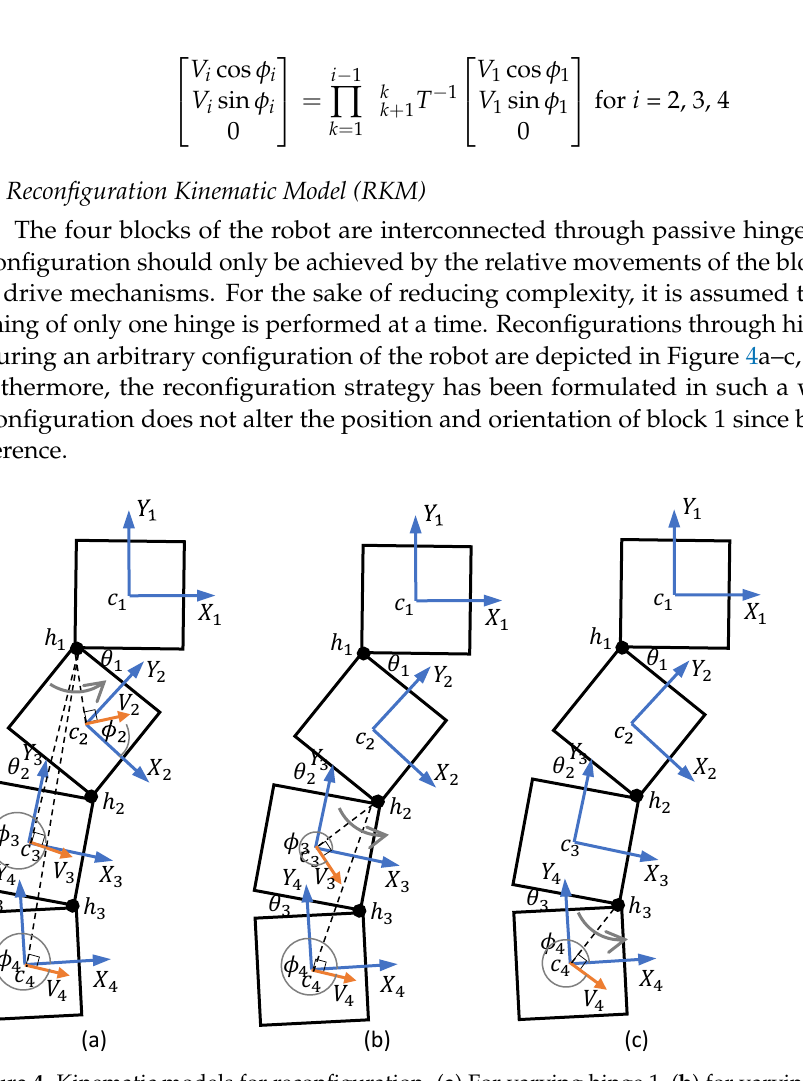
Figure 4. Kinematic models for reconfiguration. ( a ) For varying hinge 1, ( b ) for varying hinge 2, and ( c ) for varying hinge